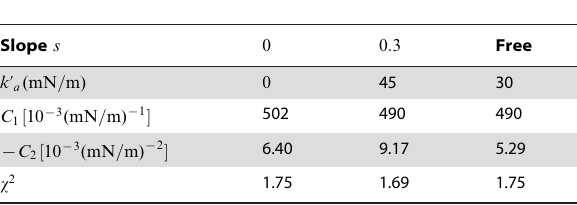
Table 3. Values of k ’ a , C 1 and C 2 obtained from our model that yield the best agreement with the experimental results of Ref. [18], analyzed with a quadratic fit (see Eq. 18 and Fig. 7).